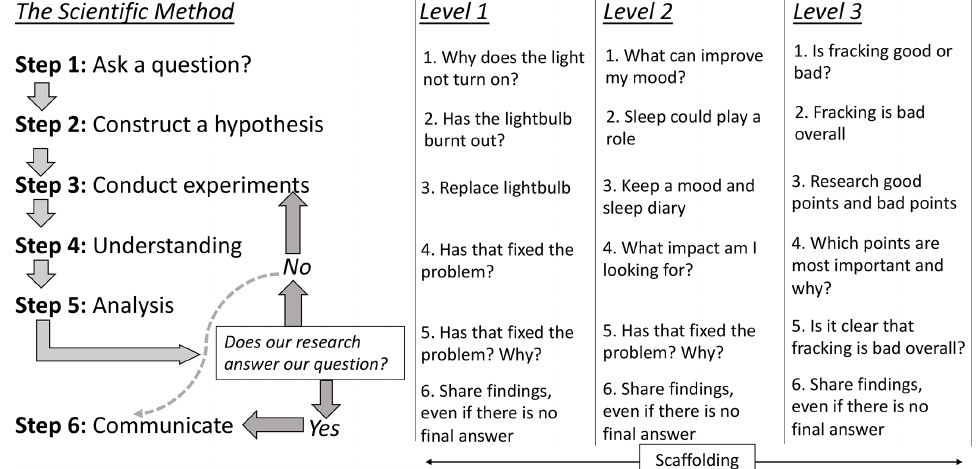
Figure 1. The scientific method and examples. A framework for conducting scientific research is known as “the scientific method”. All scientific studies follow these basic principles, but they are applicable to everyday activities and can be used to improve critical thinking. Examples show the scaffolding technique to build up the levels of questioning (e.g. Vygotsky’s sociocultural theory and his learning concept of the zone of proximal development, ZPD; Berk and Winsler, 1995). An important part is to understand that a negative result (e.g. not fully understanding a problem) is part of the process and can also be